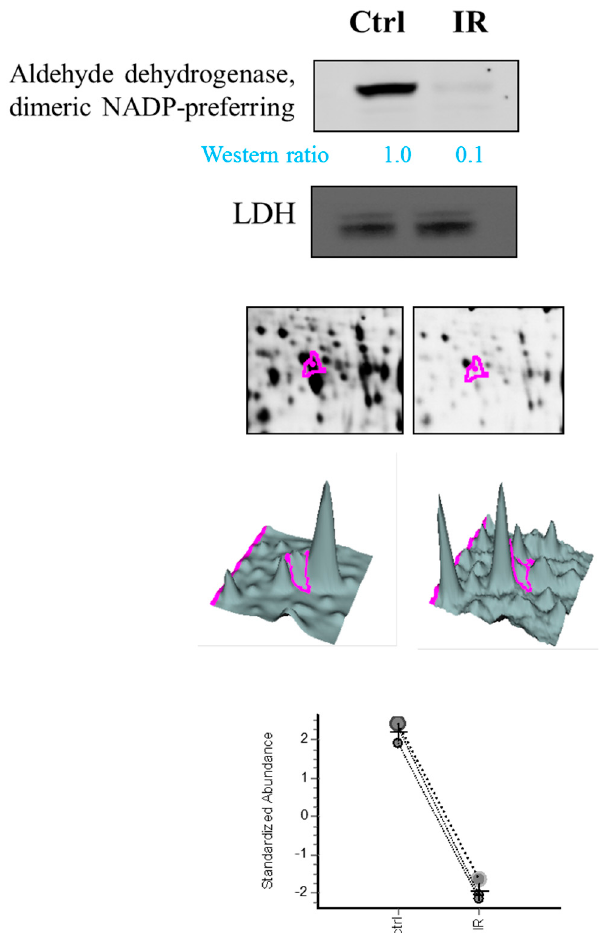
Figure 7. Representative immunoblotting analysis for selected differentially expressed protein identified by proteomic analysis between control groups and ischemia-reperfusion groups. The levels of identified proteins, Aldehyde dehydrogenase, dimeric dimeric nicotinamide adenine dinucleotide phosphate (NADP)-preferring, confirmed by immunoblot (top panels), with LDH (Lactate dehydrogenase) as loading controls. Protein expression map and three-dimension spot image are also shown. (The pink lines annotate the particular spot).